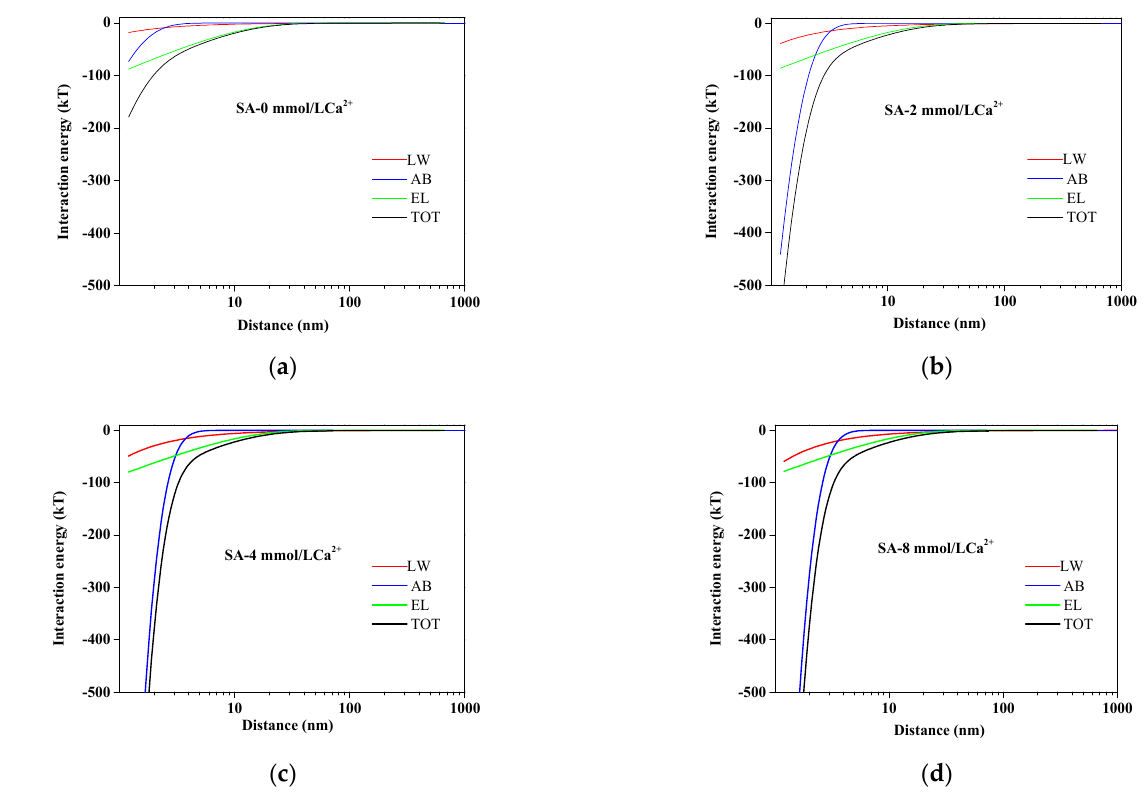
Figure 1. Variation of AEM-SA interaction energy profiles at different calcium ion concentrations: ( a ) SA without Ca 2+ ; ( b ) SA with 2 mmol/L Ca 2+ ; ( c ) SA with 4 mmol/L Ca 2+ ; ( d ) SA with 8 mmol/L Ca 2+ .